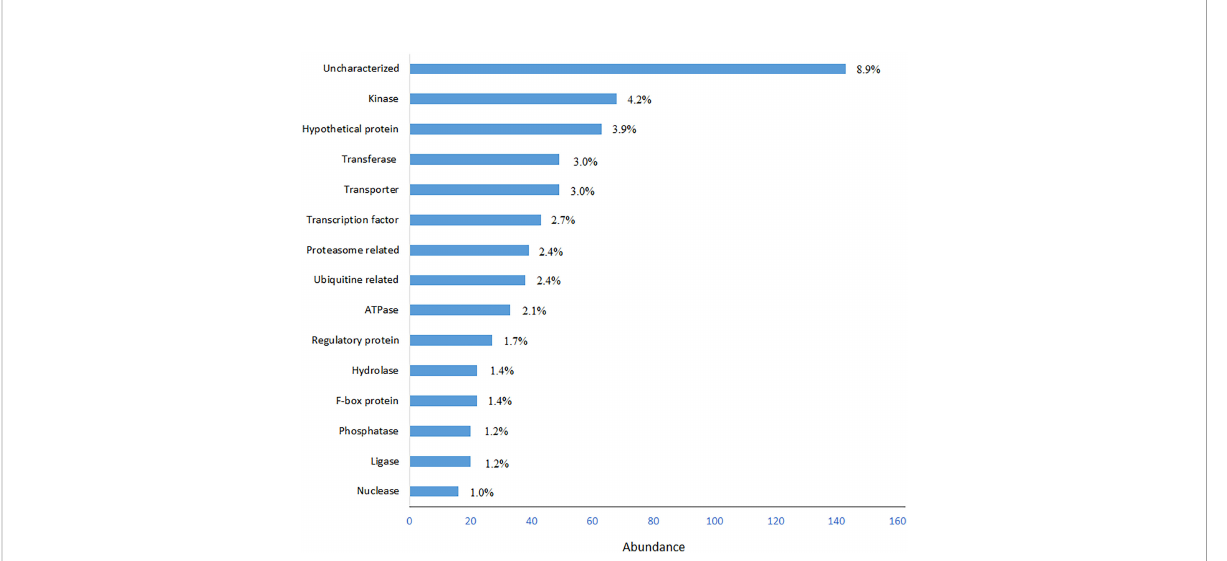
FIGURE 2 Frequency distribution of most abundant BLASTp hits of SSR-containing genes. Functional classes with ≥ 10 hits (in total, 652 hits) were used for drawing the graph.